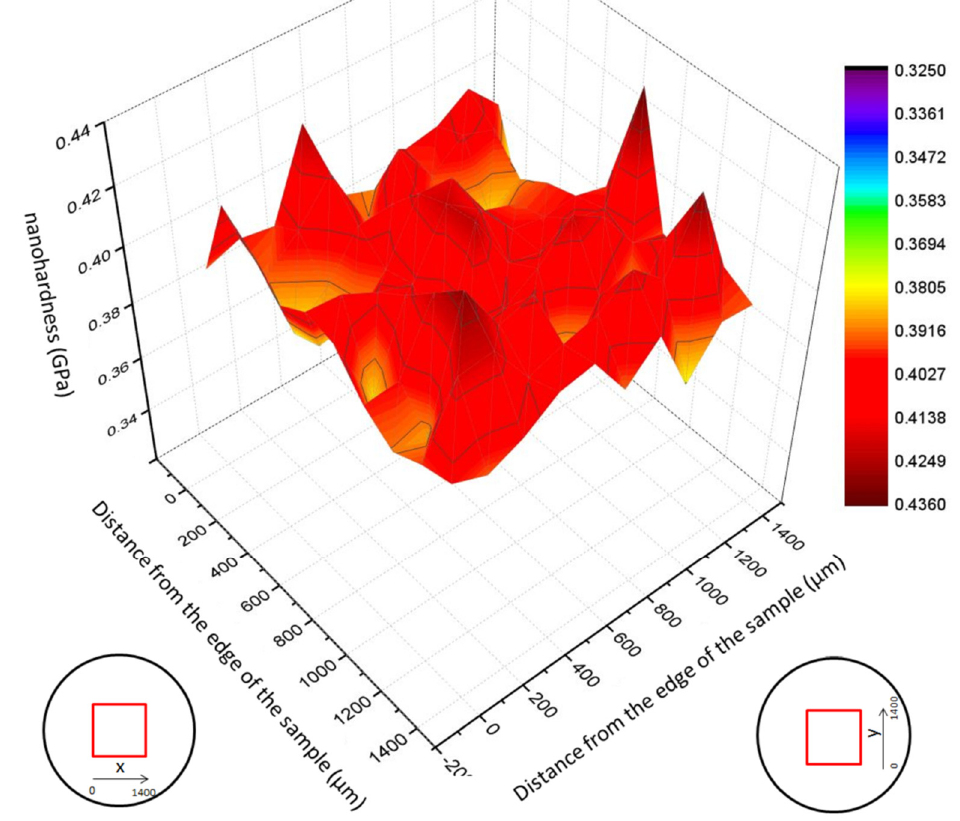
Figure 3. The nano-hardness of the initial state.